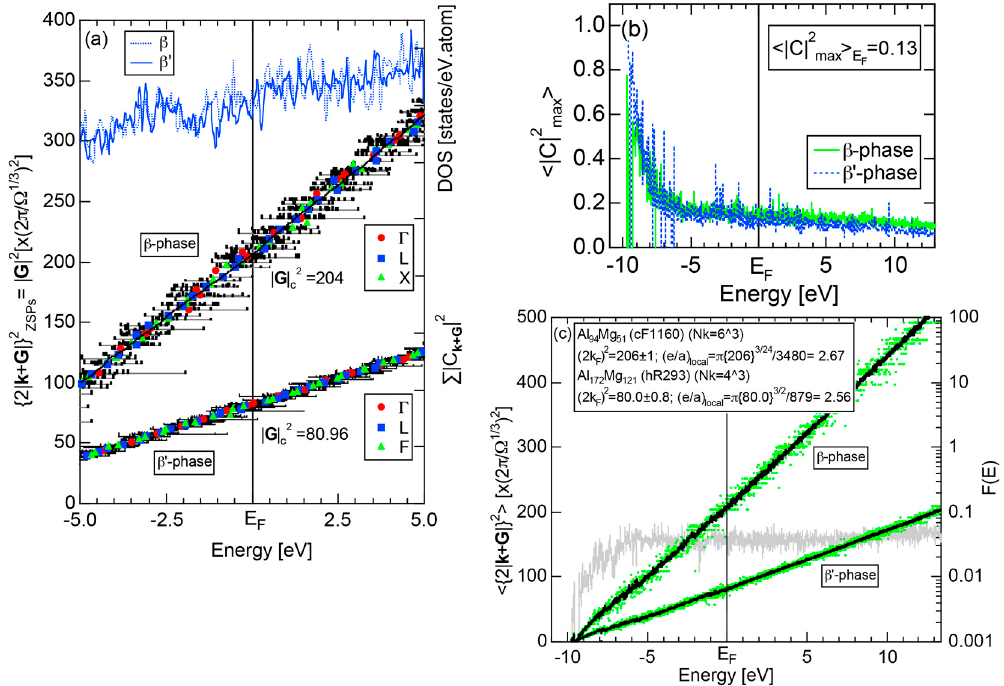
Figure 50. ( a ) FLAPW-Fourier spectra at symmetry points Γ , L, X of the fcc Brillouin zone and at symmetry points of Γ , L, F of rhombohedral lattice; ( b ) C max2 β - and for β (cid:48) -phase Al 3 Mg 2 compounds, respectively [11]. Full- and dotted- blue curves in ( a ) indicate the total DOSs for the respective phases.